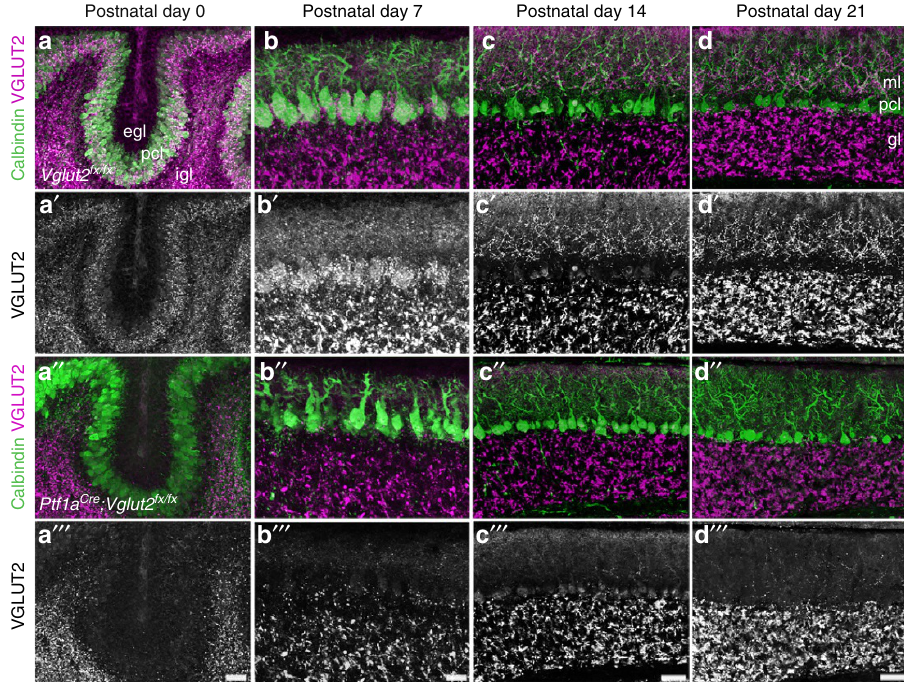
Figure 5 | Molecular layer thickness is abnormal in Ptf1a Cre ;Vglut2 fx/fx mutant cerebella during the early postnatal ages but recovers with age. ( a ) At postnatal day 0, the Purkinje cell layer is thinner in Ptf1a Cre ;Vglut2 fx/fx mutants and VGLUT2 expression is not present in the Purkinje cell layer. ( b ) At postnatal day 7, the molecular layer is significantly thinner in the mutants and there is little to no VGLUT2 expression in the Purkinje cell layer ( P ¼ 2.3 (cid:2) 10 (cid:3) 4 ). ( c ) At postnatal day 14, the Purkinje cell layer in Ptf1a Cre ;Vglut2 fx/fx mutants is only slightly thinner than the molecular layer of Vglut2 fx/fx controls and VGLUT2 expression is largely absent in the Purkinje cell layer. ( d ) At postnatal day 21, the Purkinje cell layer in Vglut2 fx/fx mice is nearly the same thickness as that observed in Ptf1a Cre ;Vglut2 fx/fx mice even though VGLUT2 expression is eliminated from the Purkinje cell layer. egl, external granular layer; pcl, Purkinje cell layer; igl, internal granular layer; ml, molecular layer; gl, granular layer. Scale bars ( a ’’’ and b ’’’), 20 m m. Scale bars ( c ’’’ and d ’’’), 50 m